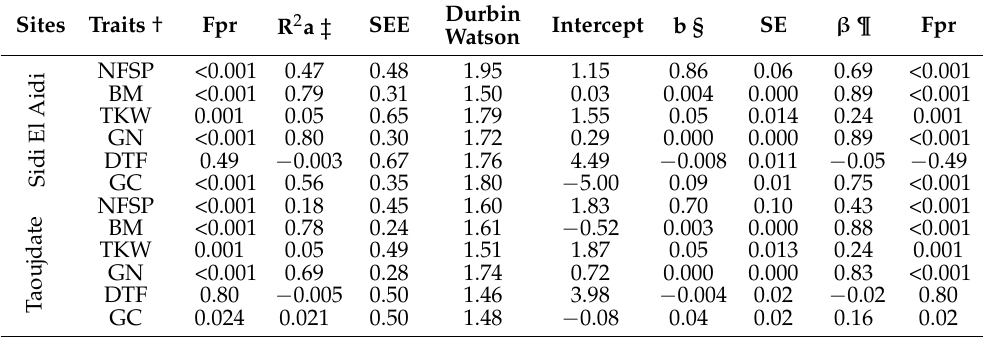
Table 2. Regression model analysis for grain yield prediction through secondary traits. Sites Traits †